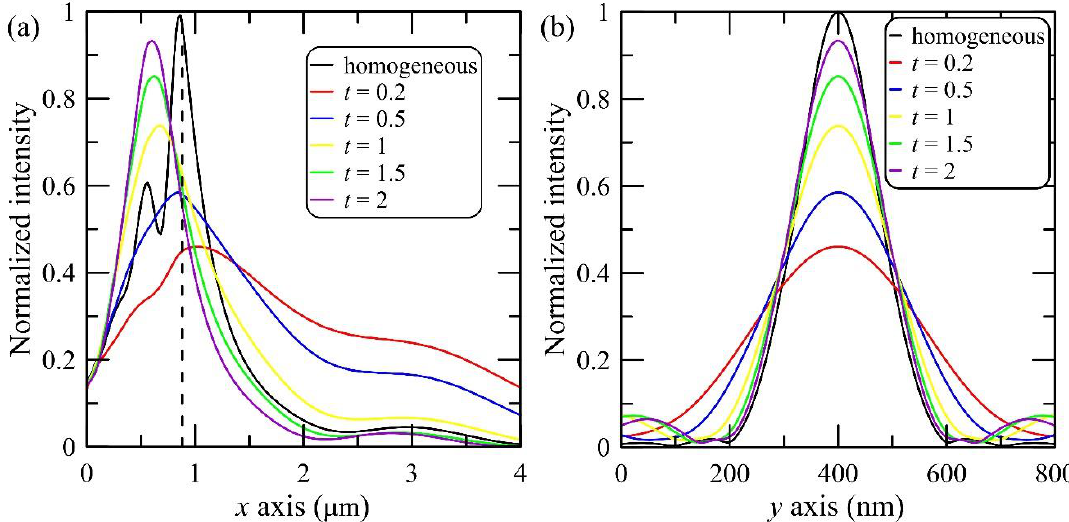
Figure 4. Normalized intensity distributions of photonic nanojet for cylindrical graded-index lens along ( a ) the propagation axis ( x axis) and ( b ) the transversal axis ( y axis). The dashed line is the edge of the lens.